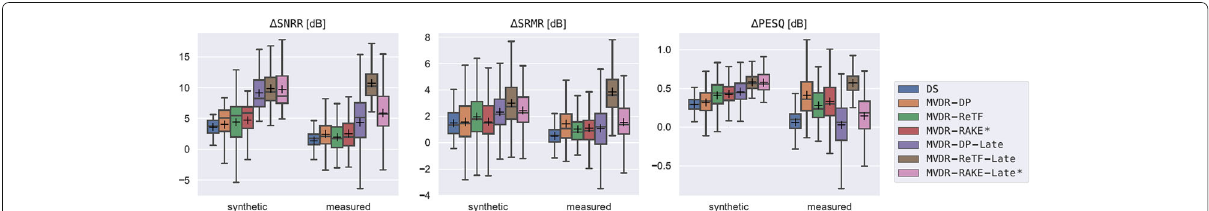
Fig. 7 Boxplot showing the comparison of different echo-agnostic and echo-aware (*) beamformers for the room configuration 011111 ( RT 60 ≈ 730 ms) on measured and synthetic data for all combinations of source array positions in the dEchorate dataset. The mean values are indicated as + , while whiskers indicates extreme values